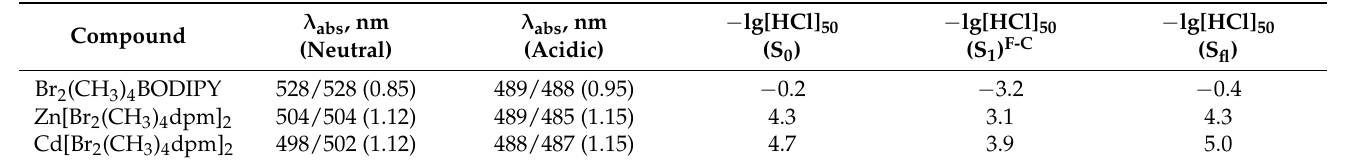
Figure 1. Changes in the absorption ( a ) and fluorescence ( λ ex = 470 nm) ( b ) spectra of Br 2 (CH 3 ) 4 BODIPY in ethanol upon the addition of 36% (11.6 M) HCl, in varying amounts. Ex- perimental titration curves for the ground state S 0 ( λ = 528 nm) ( c ) and excited state S 1 ( λ = 544 nm) ( d ). Table 1. Stability characteristics of the dpm complexes in proton-donor media for the ground (S 0 ), Frank–Condon (S 1 ) F-C , and fluorescence (S fl ) states. Experimental/calculated * absorption ( λ abs ) wave-lengths (in parentheses), with oscillator strengths of the compounds in ethanol solvent, neutral and acidified, using hydrogen chloride